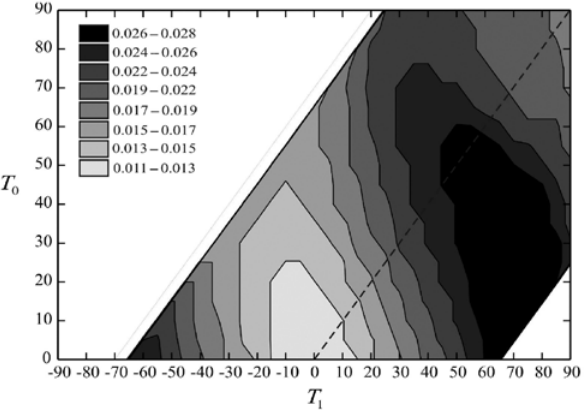
Figure 9: Contour plot of Ω for the soft simply supported boron/ epoxy [  〈 T / T 〉] circular laminate. 0 1 s